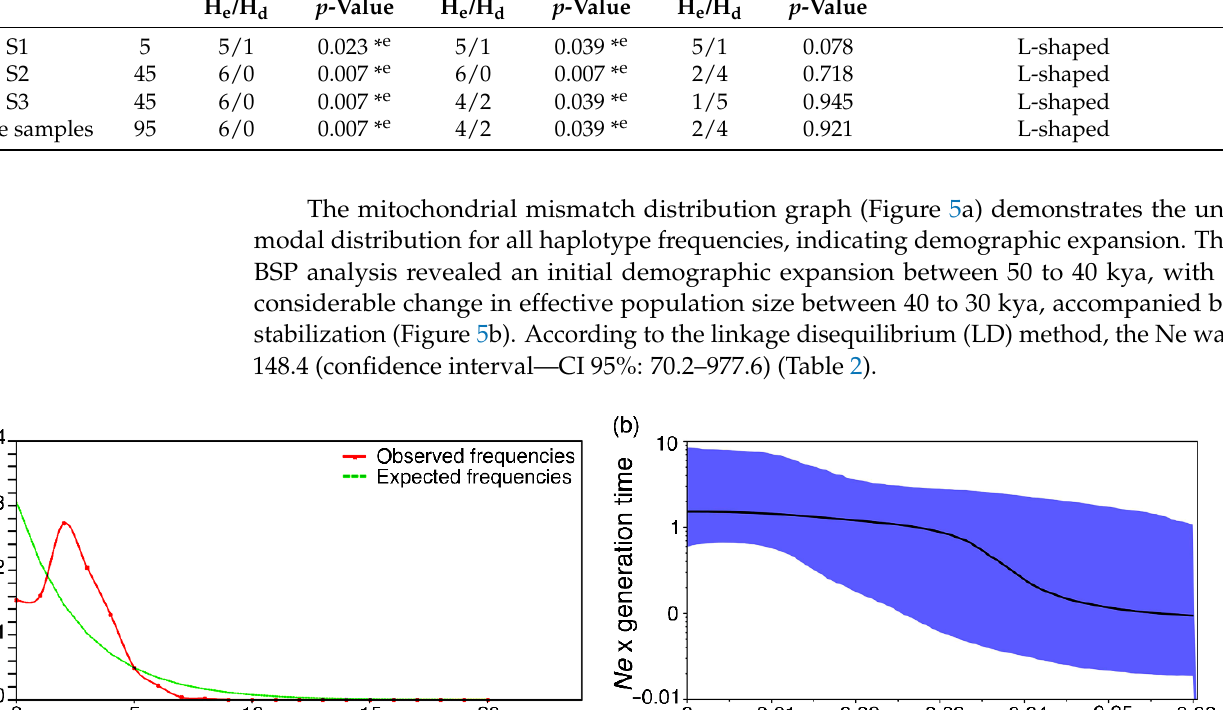
Table 3. Bottleneck tests on 95 samples of Steindachneridion melanodermatum collected from the Lower Iguaçu River. Wilcoxon signed-rank test for excess heterozygosity and mode-shift test for allelic frequency distribution patterns. N—number of individuals; He—number of loci exhibiting excess heterozygosity; H d —number of loci exhibiting low heterozygosity. * e Significant values for excess heterozygosity ( p ≤ 0.05). Normal L-shaped distribution = non-bottlenecked population. a Infinite allele model, b Two-phase model (90% SSM), and c Stepwise mutation model.